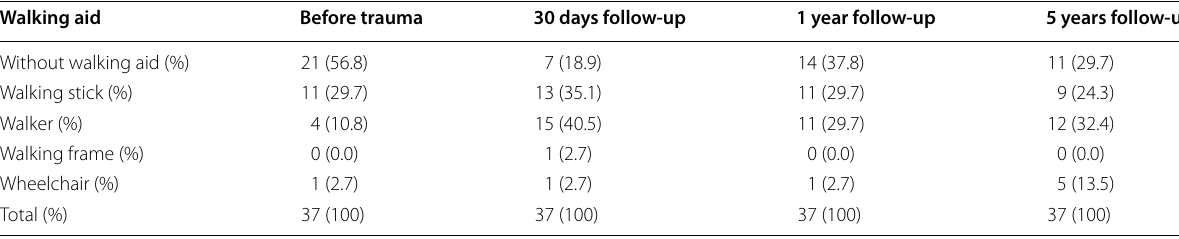
Table 2 Use of walking aids during a 5-year